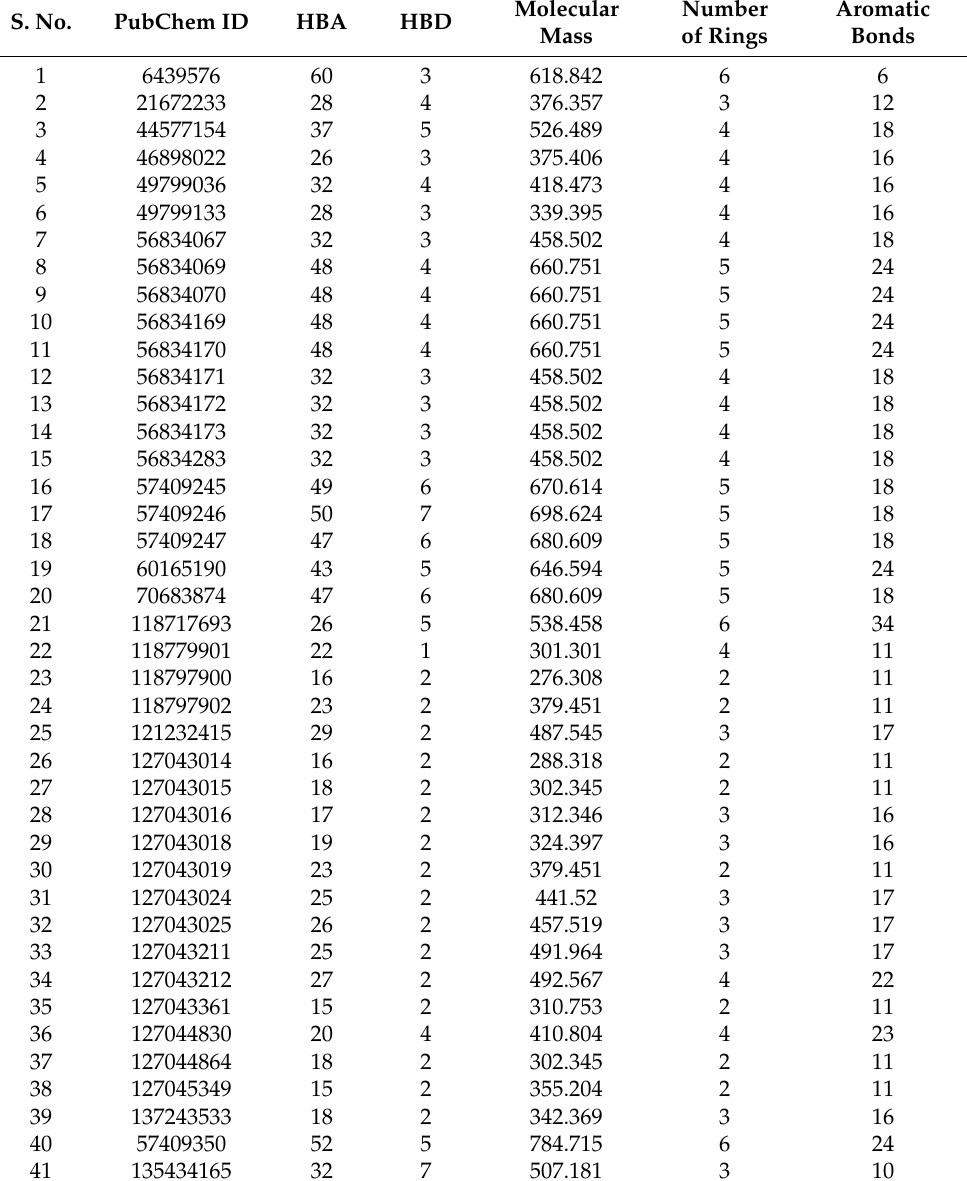
Table 1. Physicochemical properties of the 41 compounds used for building the pharmacophore model. S.